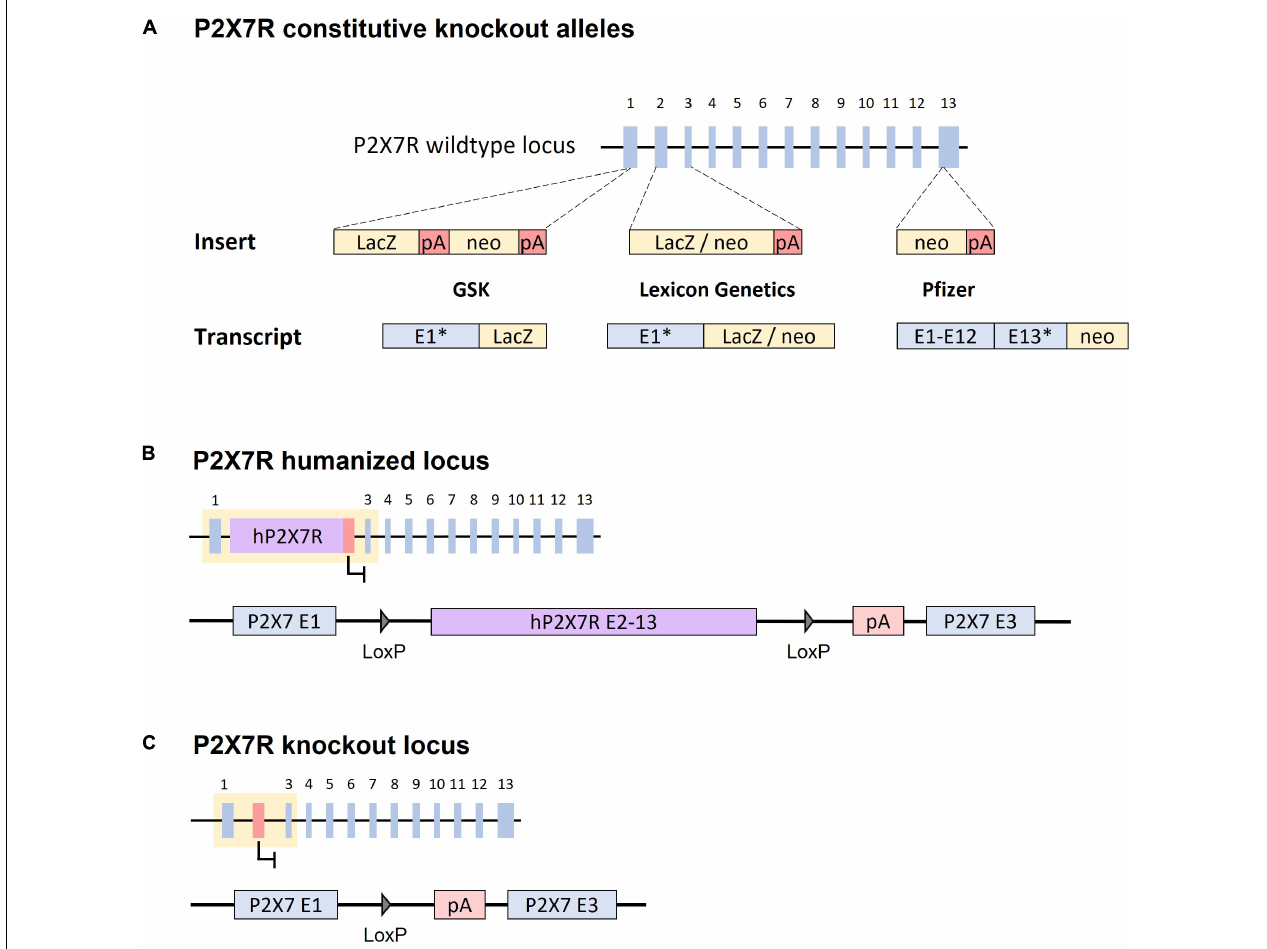
FIGURE 1 | Strategies targeting the P2RX7 gene in constitutive and conditional knockout mouse lines. (A) P2X7R constitutive knockout alleles. GSK (P2rx7 tm 1 Ipch ): a LacZ-neomycin (neo) cassette was inserted in exon 1, which results in an exon 1-LacZ fusion transcript. Lexicon Genetics (P2rx7 tm 1 Lex ): a LacZ-neomycin cassette was used to substitute exons 2 and 3, which results in an exon 1-LacZ-neo fusion transcript. Pfizer (P2rx7 tm 1 Gab ): a neomycin cassette was inserted in exon 13, which truncates the transcript in the C-terminal region. “ ∗ ”: truncated P2X7R exon. Dashed lines indicated the insertion site of the construct. (B) Humanized P2X7R locus. The human cDNA sequence from exon 2–13 substitute’s murine exon 2. The cDNA sequence is flanked by LoxP sites. (C) P2X7R conditional knockout locus. Upon Cre recombinase activity, the cDNA fragment is deleted resulting in a disrupted P2RX7 gene. The loss of exon 2 prevents the expression of any functional P2X7R variants. “pA/red box”: Polyadenylation